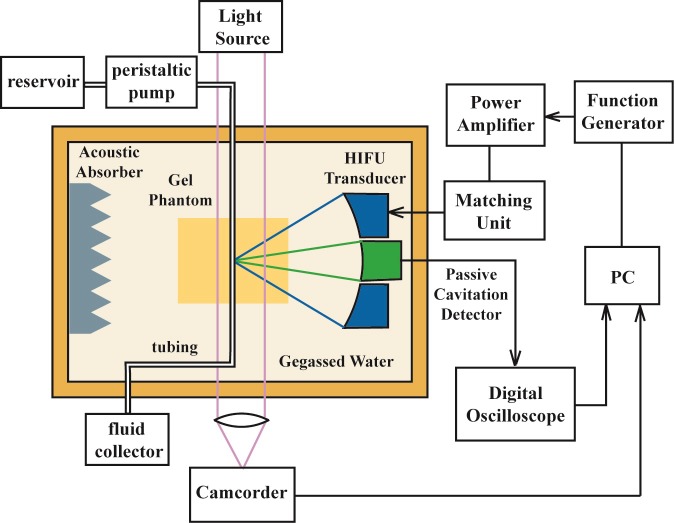
Schematic diagram of experimental setup for HIFU ablation for a tubing embedded in the gel phantom and passive cavitation detection.